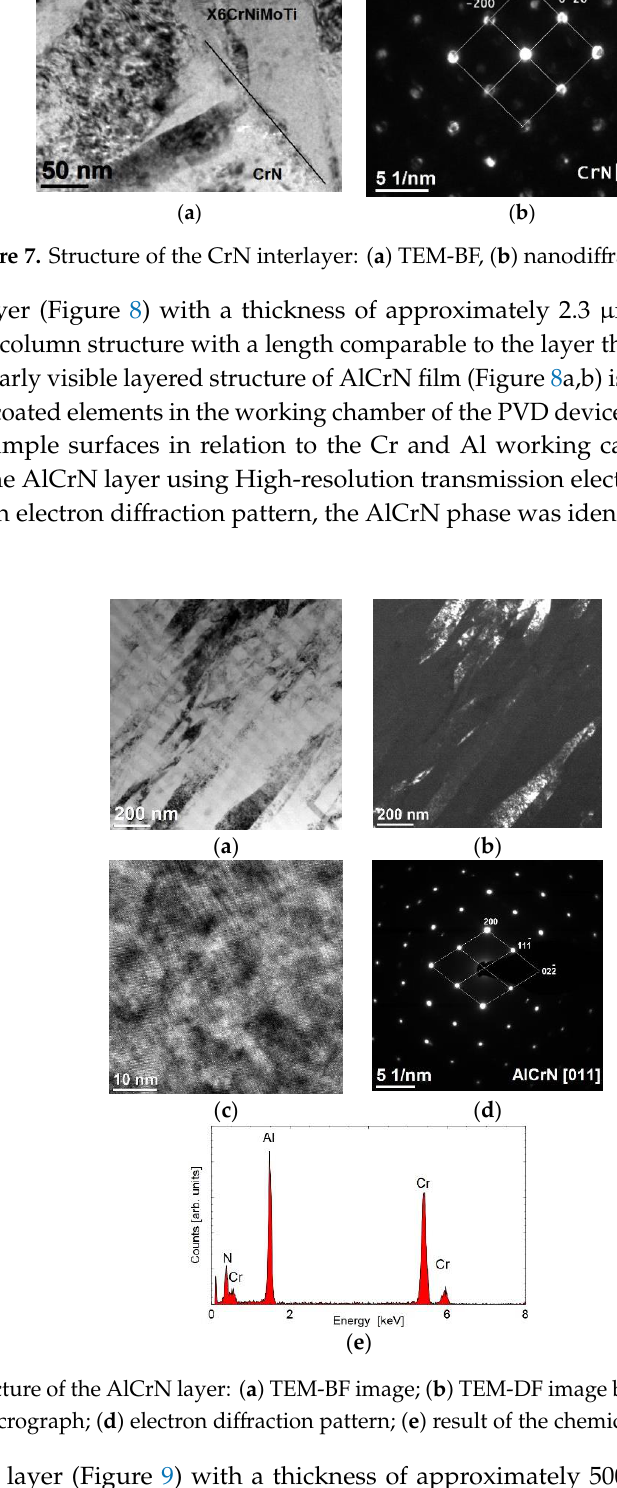
Figure 6. ( a ) STEM-BF image of AlCrN + CrCN coating; ( b ) result of the chemical composition profile analysis; ( c ) result of the chemical composition analysis of the substrate material.